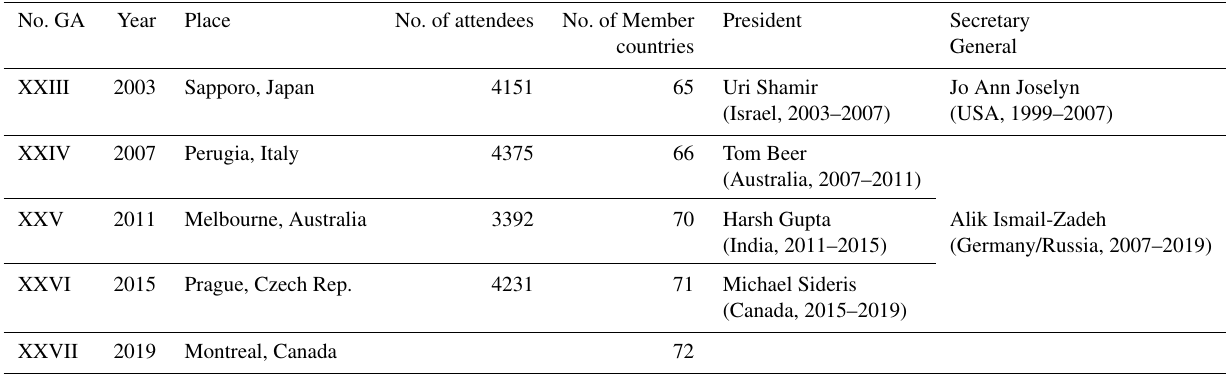
Table 2. IUGG General Assemblies (GA) from 1999 to 2019, and IUGG Presidents and Secretaries General elected. No.